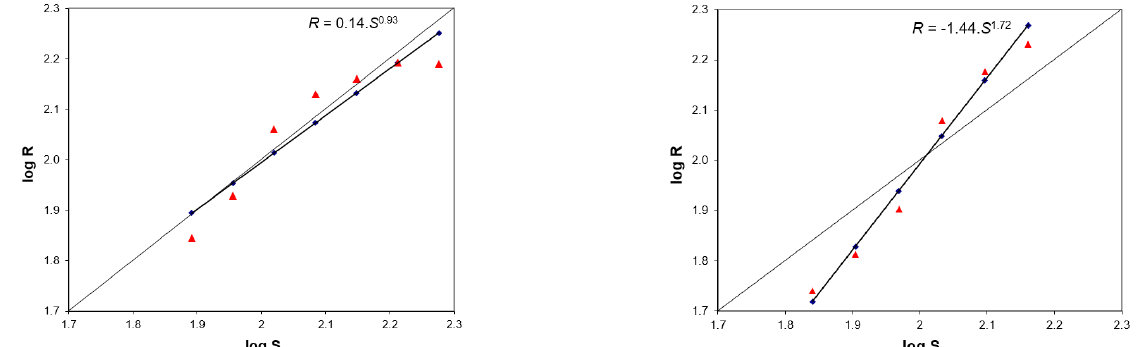
Figure 4. Di-log plots of perceived size of body in images (psychological scale) and the actual size of distorted body images (physical scale), using logarithmic values for estimations of magnitude of two different individuals. The first shows a perceptual constancy ( left side ) and the second, a perceptual overconstancy ( right side